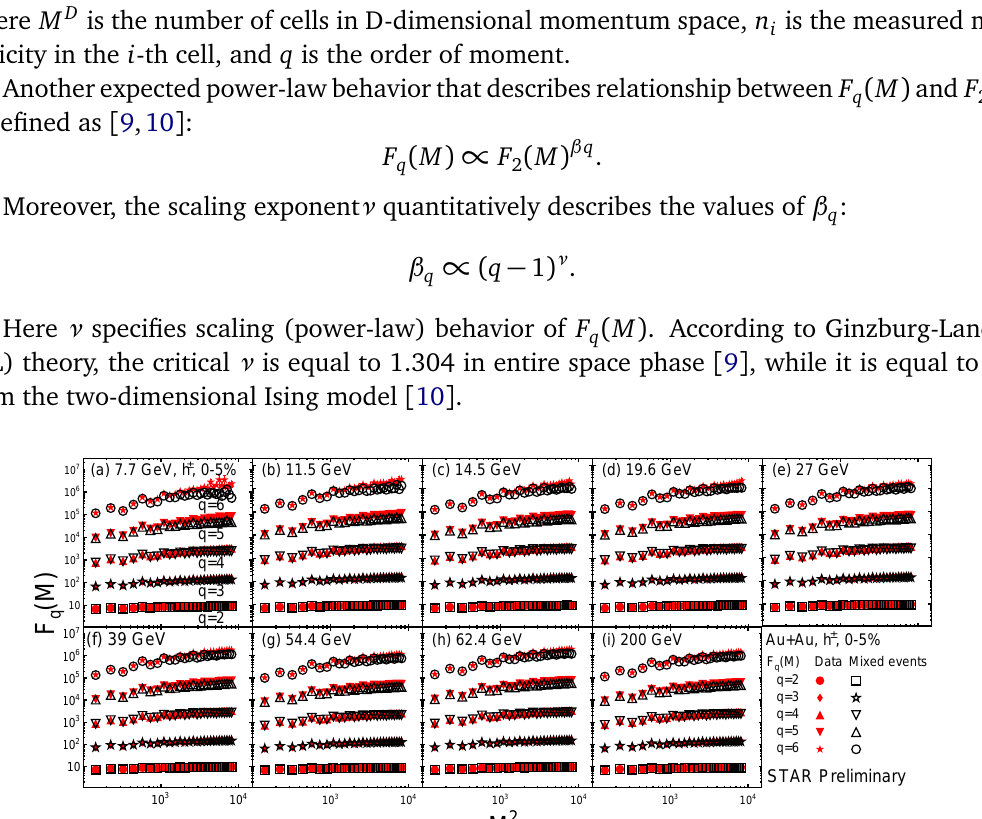
(cid:112) = 7.7-200 GeV in s NN